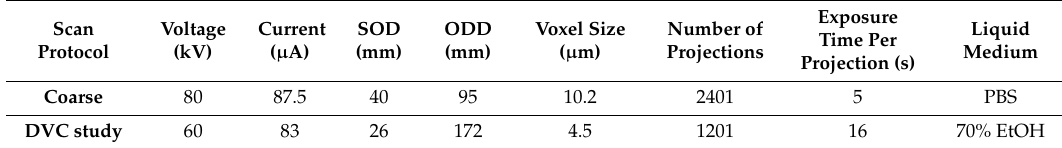
Table 1. X-ray micro-computed tomography parameters for scanning the extracted tissue-biomaterial sample. A coarse scan was taken to provide initial evaluation of the interior interface. In situ testing was then carried out with scans taken under successive load to permit study of deformation mechanics using DVC. SOD = Source to Object Distance, ODD = Object to Detector